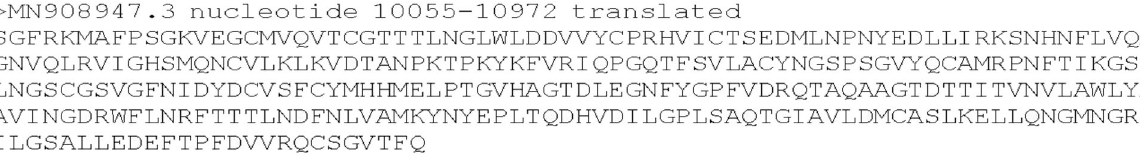
Fig. 2 Translated region of the 2019-nCoV nucleotide sequence with the full sequence forming the target protein coding